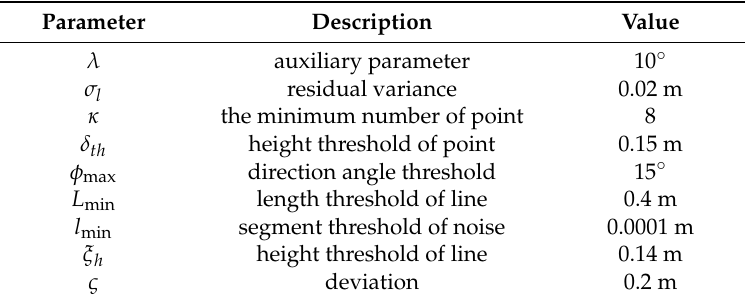
Table 3. Parameters for Obstacle Detection.